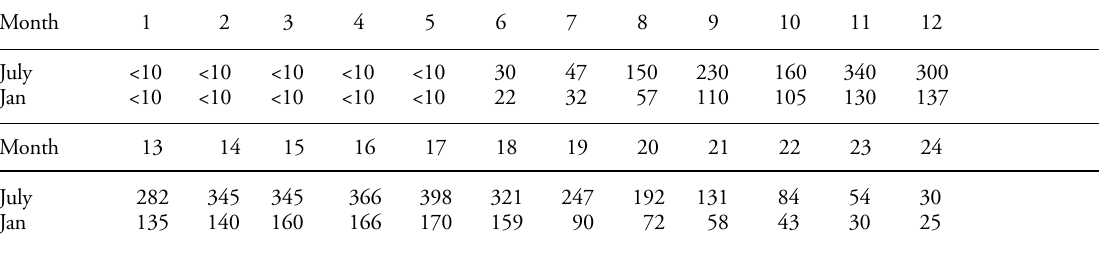
Table 4. Mean traffic flow per hour – July and January on A470(T) in mid Wales.